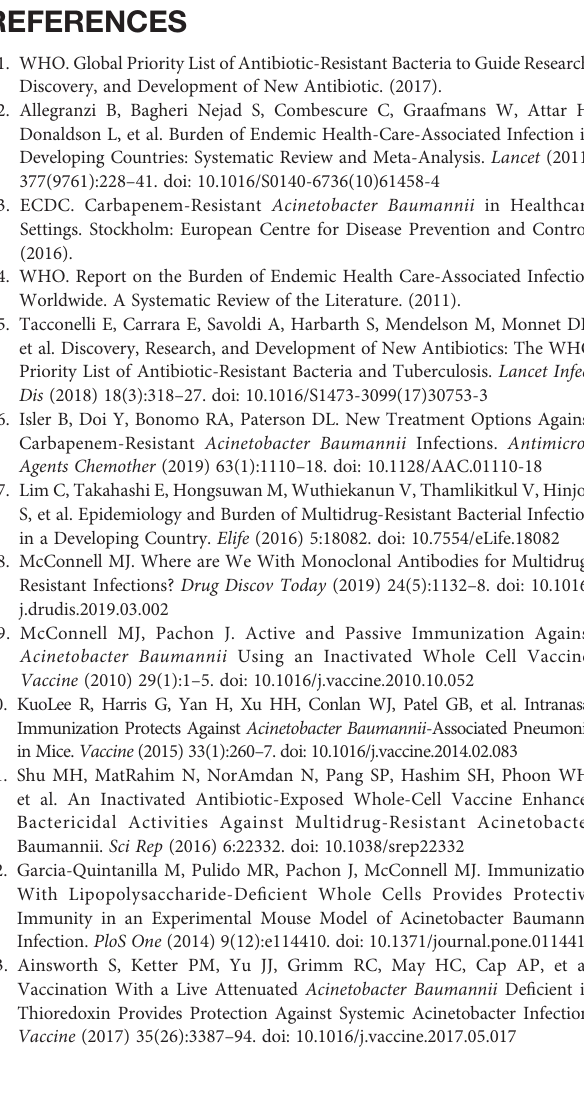
Supplementary Figure 1 | Growth inhibitory activity of unencapsulated AB5075 D wza isolates by mouse antisera. 10 2 CFU of un-encapsulated AB5075 D wza strain was incubated in triplicate with either, AB5075 WT antisera (black line, solid diamond), AB5075 D wza antisera (black line, open diamond) and sera from non- immunized mice (grey line, solid circle) (A) or AB3879 antisera (black line, solid square), multi strain antisera (black line, open square), and sera from non-